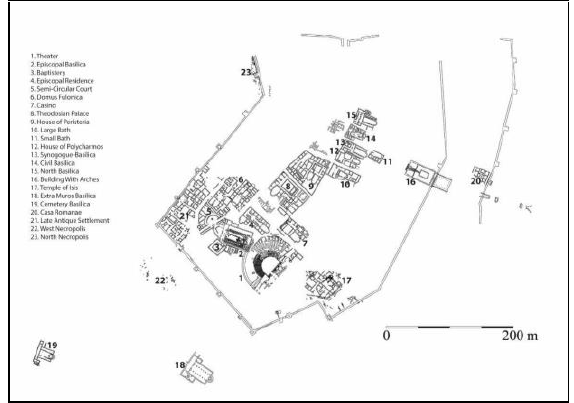
Figure 1. Ground Plan of Stobi in Current Excavation State